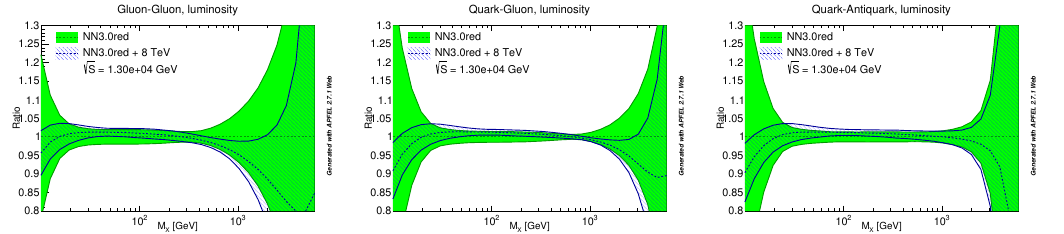
cut on the gluon and singlet-quark distributions. T